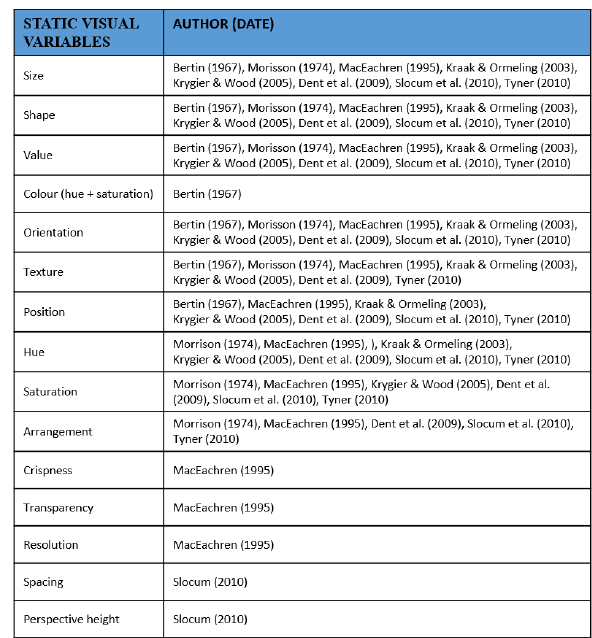
Table 1. Static visual variables distinguished over the last fifty years inspired from Halik (Halik,